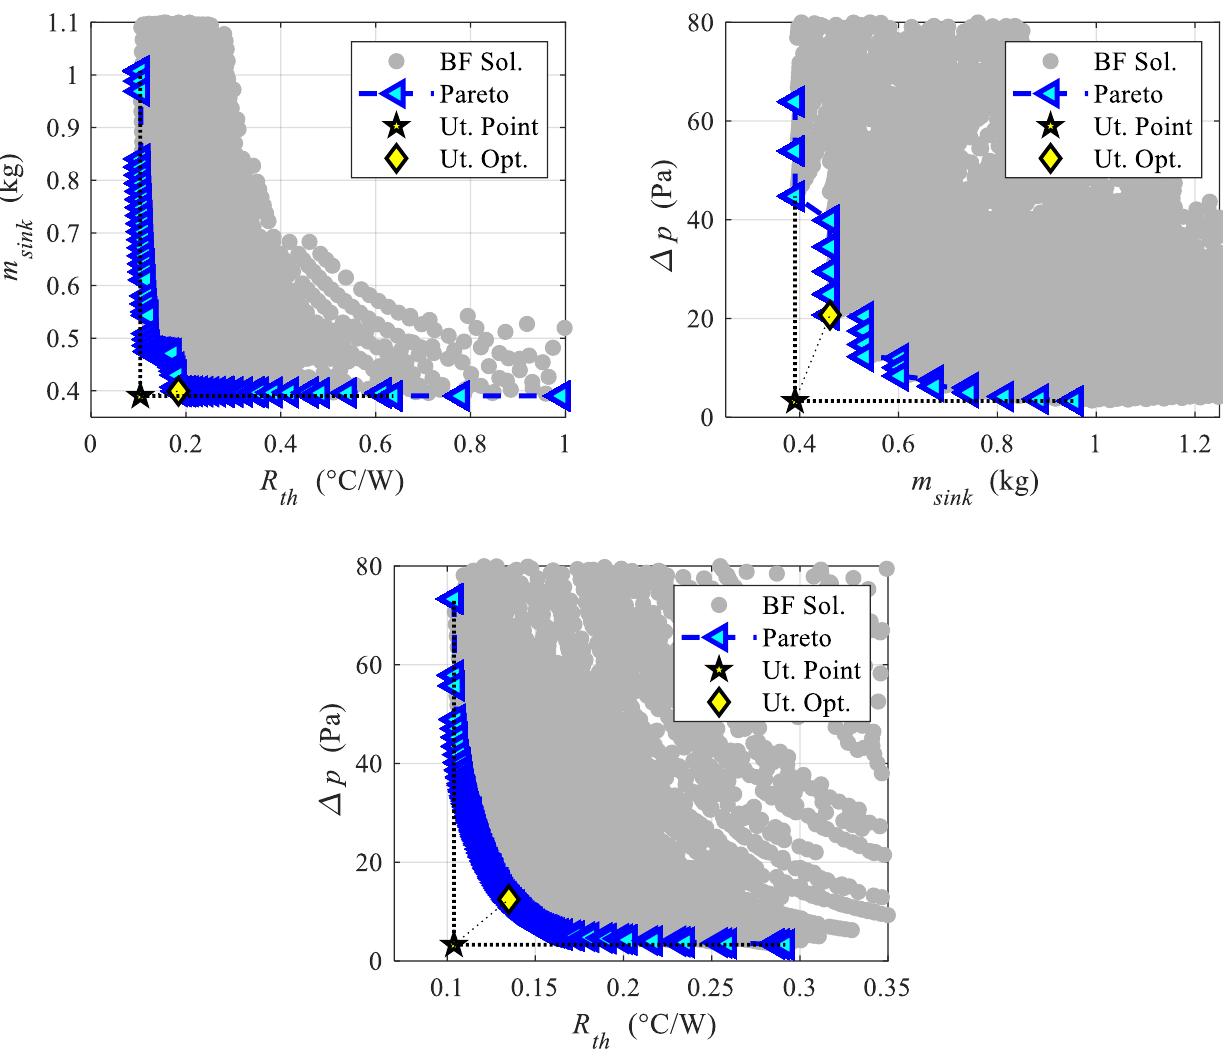
Figure 4. 2D Solutions extrapolated from 3D solutions for different couples of objective functions.